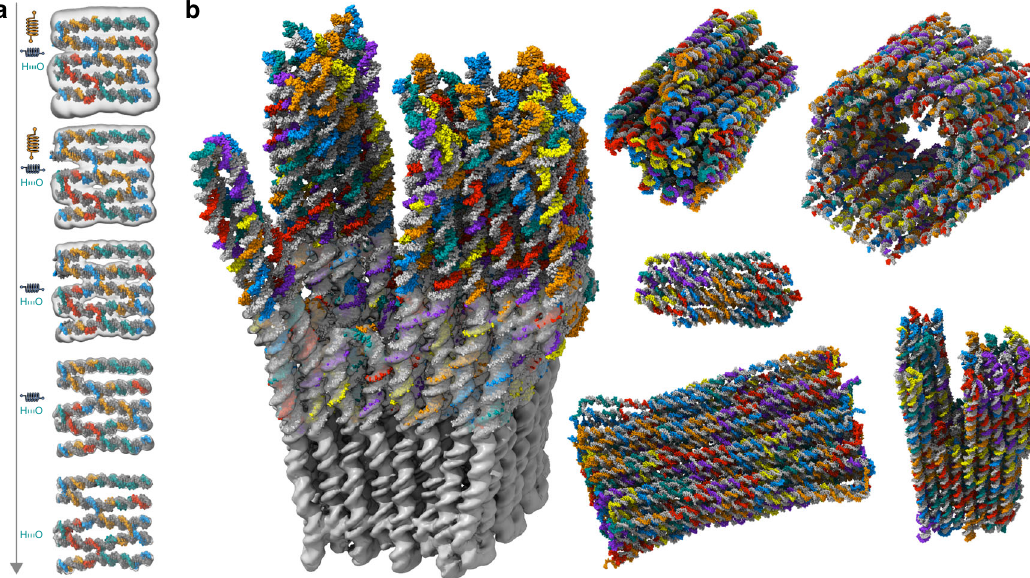
Fig. 5 Semiautomatic atomic model construction. a Schematic illustration of the cascaded relaxation procedure. Markers along the arrow represent secondary restraints applied to the structure: interhelical (orange, vertical springs), intrahelical (blue, horizontal springs), and hydrogen bonds of the Watson – Crick pairs (H – O). b Atomic models derived from fi tting to cryo-EM maps: Twisttower (overlay with map), Pointer-v2, 126-helix bundle, 16-helix bundle, 48-helix brick, and twist-corrected Twisttower. Scaffold atoms are depicted in gray, staple strands in